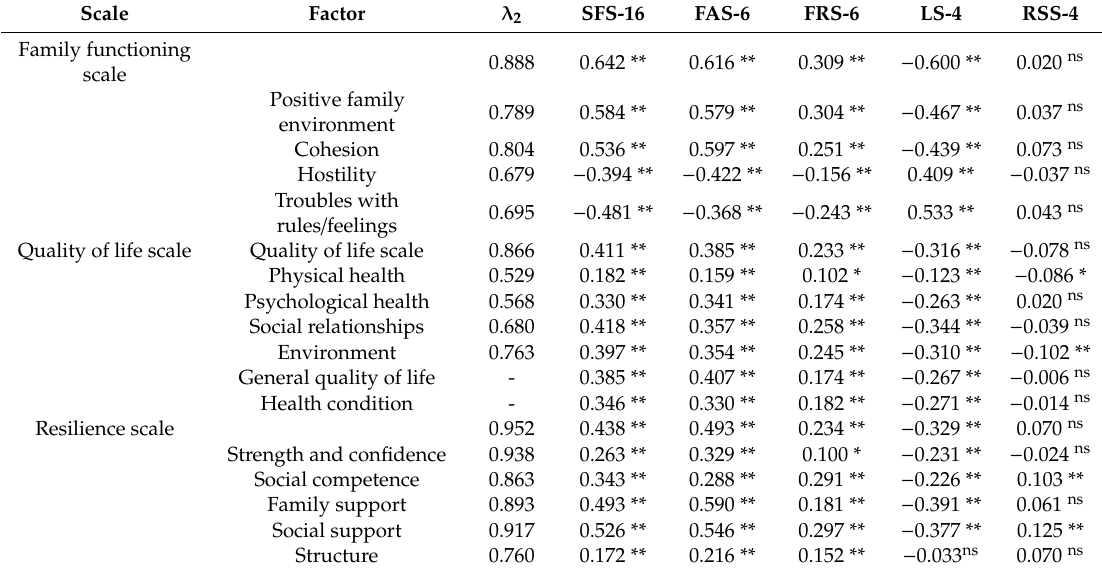
Table 6. Convergent